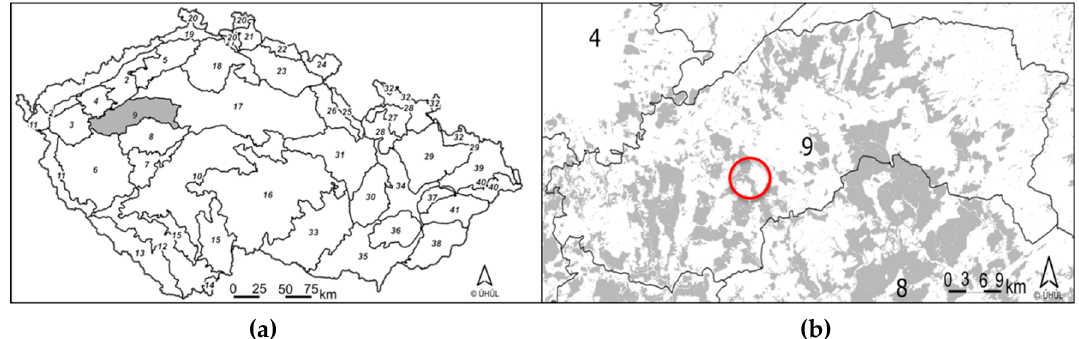
Figure 1. Forest regions of the Czech Republic; ( a ) Region 9 Rakovnik-Kladno’s upland; ( b ) Location of case study area (CSA) (gray parts represent forest area distribution).